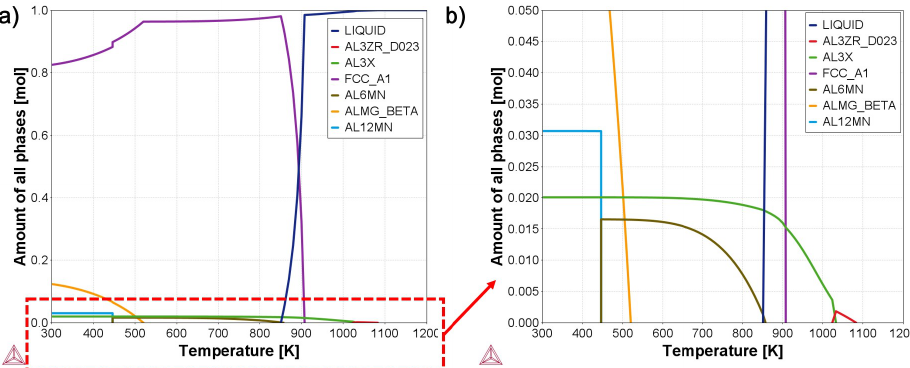
Figure 13. ( a ) One-axis equilibrium for Al-Mg-Sc-Zr alloys indicating the formation of different phases during solidification. ( b ) Zoomed-in image at low amount of phases to show that Al 3 Zr (named Al3X or Al 3 Zr _ D 023) particles are formed as primary particles before all the liquid Al has solidified. Simulation was performed using ThermoCalc2021a with TCAL7 and MOBAL5